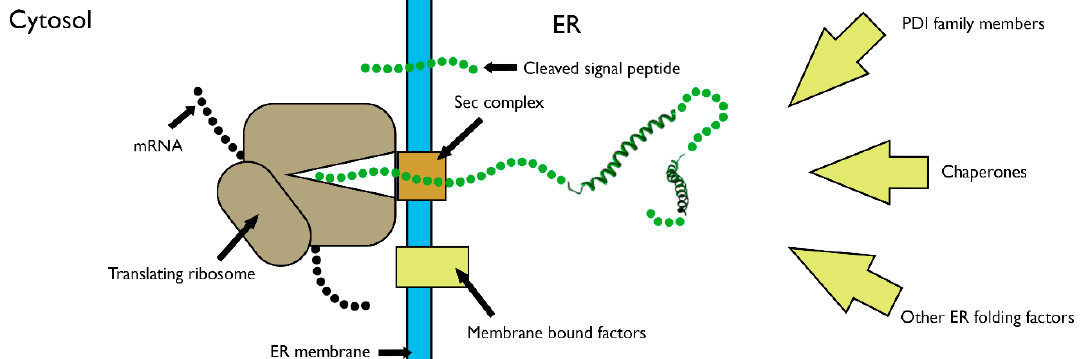
Figure 2. Folding of a ribosome-associated nascent chain during endoplasmic reticulum (ER) entry. Schematic showing a translating ribosome targeted to the ER membrane. The nascent polypeptide (green) enters the ER via the sec complex, undergoes signal peptide cleavage, and begins to fold at the ER-exposed N-terminus. Both membrane-bound and soluble ER factors can interact with the nascent polypeptide as it undergoes translocation.